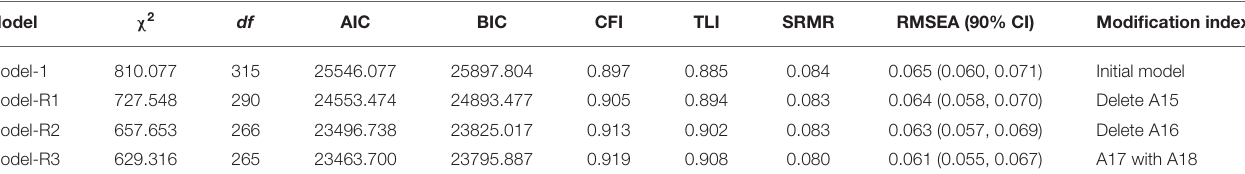
TABLE 6 | Model fit indices for abbreviated EOQ models.